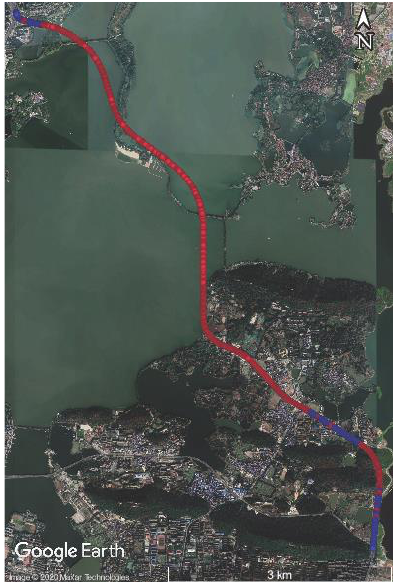
Figure 7. Trajectory of the East Lake Tunnel test.